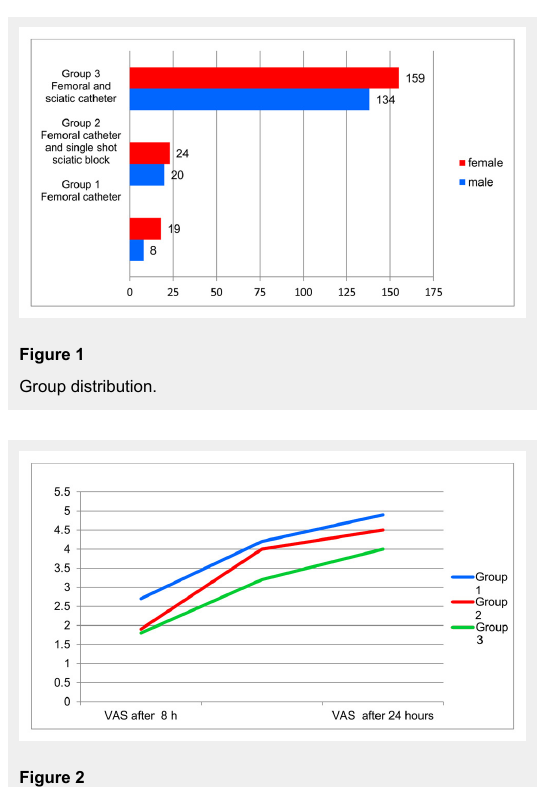
Development of VAS score over time with different catheter